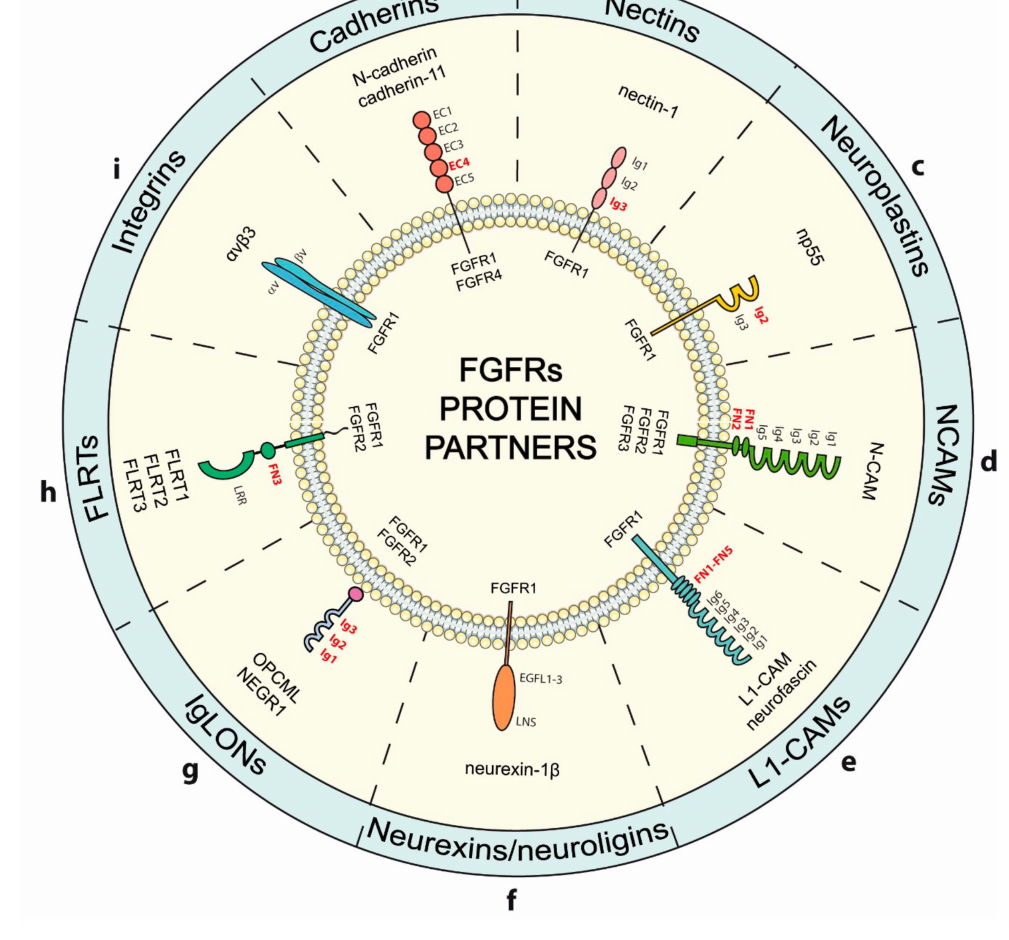
Figure 2. Cross-talk between FGFRs and various cell adhesion molecules. The interaction of particular FGFR with members of CAMs subgroup is indicated. The domain architecture of FGFR partner proteins is shown. Domains (where identified) responsible for the interaction between the partner protein and FGFR are indicated in red. ( a ) Cadherins reported to interact with FGFR1 and FGFR4 contain five EC domains in their extracellular region, a single transmembrane helix, and a cytosoilc tail interacting with several signaling proteins. ( b ) Nectins are composed of three immunoglobulin-like domains Ig1–Ig3, a single transmembrane domain, and a cytosolic region. Nectins bind FGFR1 using the Ig3 domain ( c ) Neuroplastin (Np55) contains two immunoglobulin-like Ig1–Ig2 domains in their extracellular